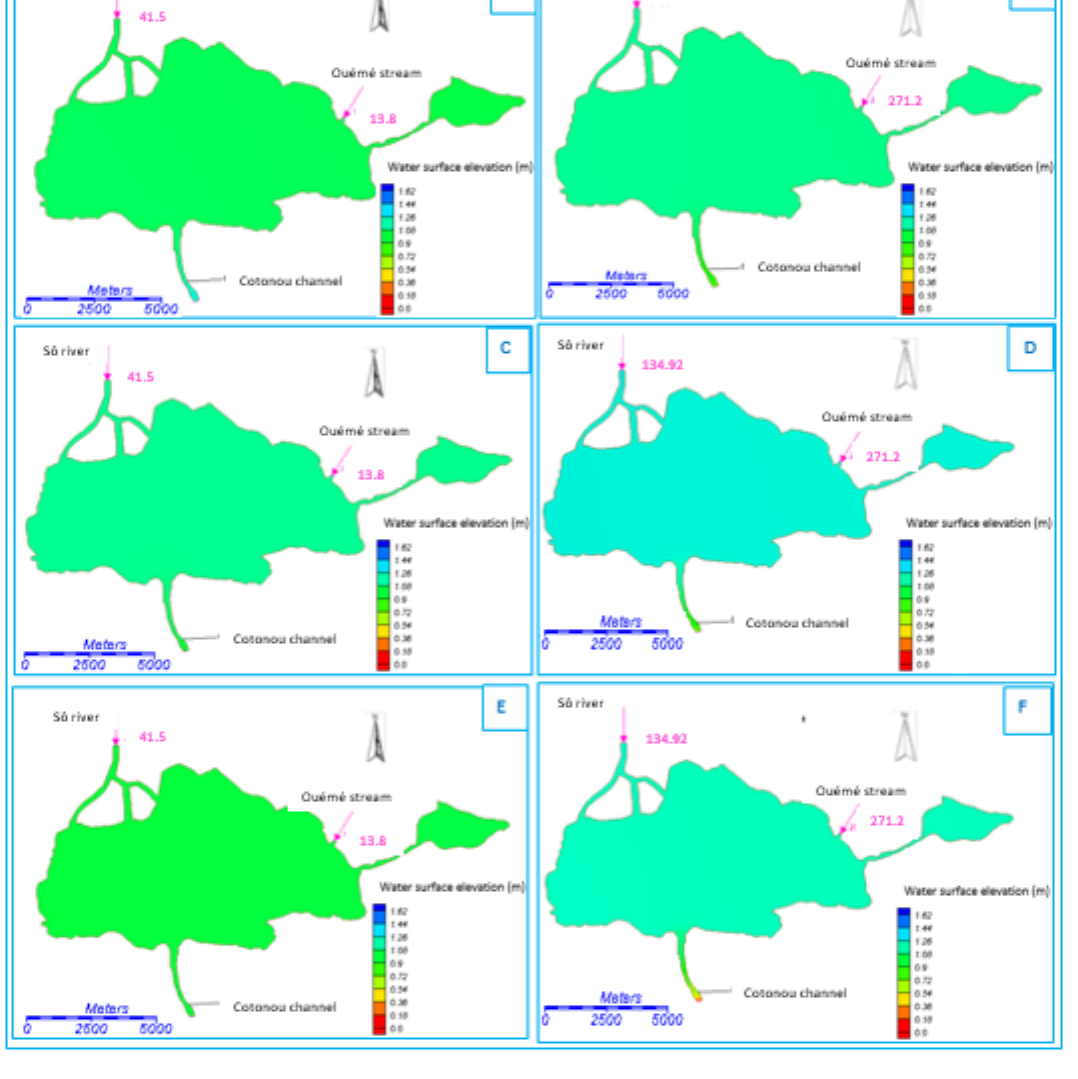
Figure 8. Spatial and seasonal variation of the water surface elevation. ( A ) Low water period/Average Tidal amplitude/High tide; ( B ) Flood period/Average Tidal amplitude/High tide; ( C ) Low water period/High Tidal amplitude/High tide; ( D ) Flood period/High Tidal amplitude/High tide; ( E ) Low water period/High Tidal amplitude/low tide; ( F ) Flood period/High Tidal amplitude/low tide.